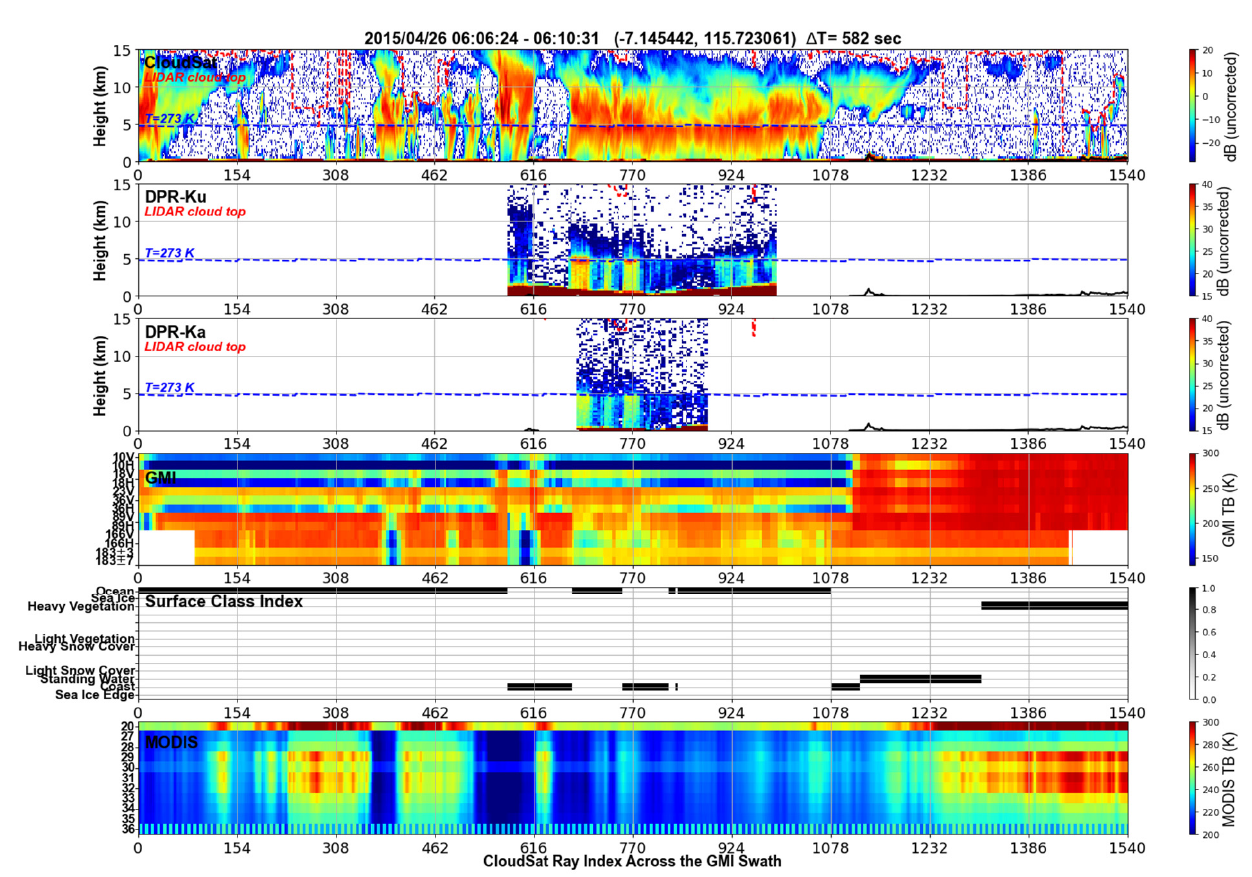
Figure 4. Radar time–height profile cross section associated with the CloudSat-GPM coincidence shown in Figure 2, showing the (uncorrected for attenuation) equivalent radar reflectivity profile (dBZ) from CloudSat, DPR Ku- and Ka-band MS (rows 1, 2 and 3, respectively) radar profiles scaled as shown in the color bar. The CloudSat ray indices (horizontal scale) are about 1-km apart, and this segment represents the distance along the CloudSat track shown in the solid black line of Figure 2. The zero-degree isotherm line is shown as a blue dashed line (labeled “T = 273 K”). The top-most cloud top as determined by the CloudSat+CALIPSO lidar dataset is shown with a dashed red line (LIDAR cloud top). The fourth row shows the line-trace of the 13 GMI channels (increasing in frequency from top to bottom), in an image format. The fifth row shows the TELSEM surface class along the CloudSat track. The sixth row shows the TB from the eleven MODIS thermal channels (channels 20, and 27–36).